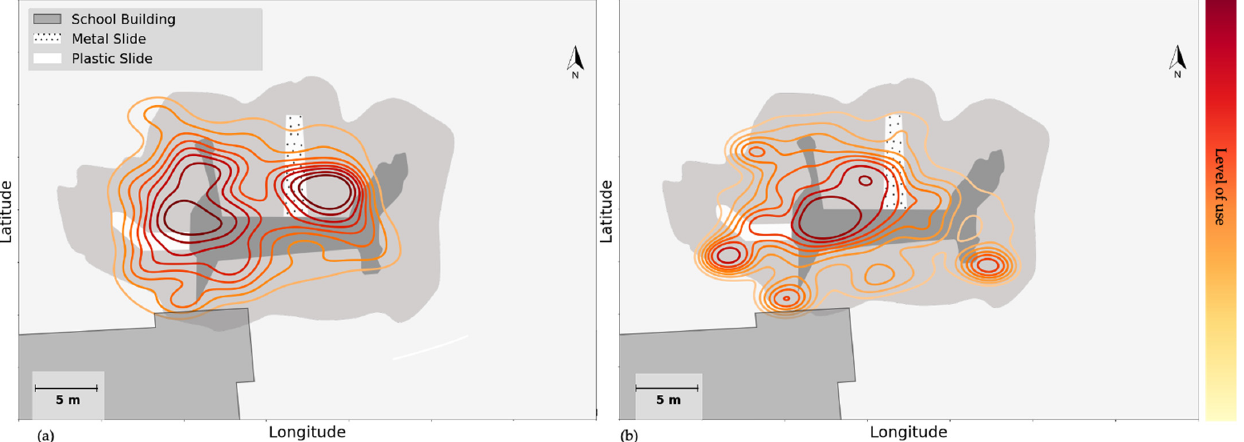
Figure 4. Use of space, around the slides on multi-functional structure, analysed by GPS data, during (a) the morning break, and (b) the lunch break in school B. The level of use is analysed via GPS data, and obtained contours are colour coded from the lowest level of use to the highest following the colour bar (from yellow to red).